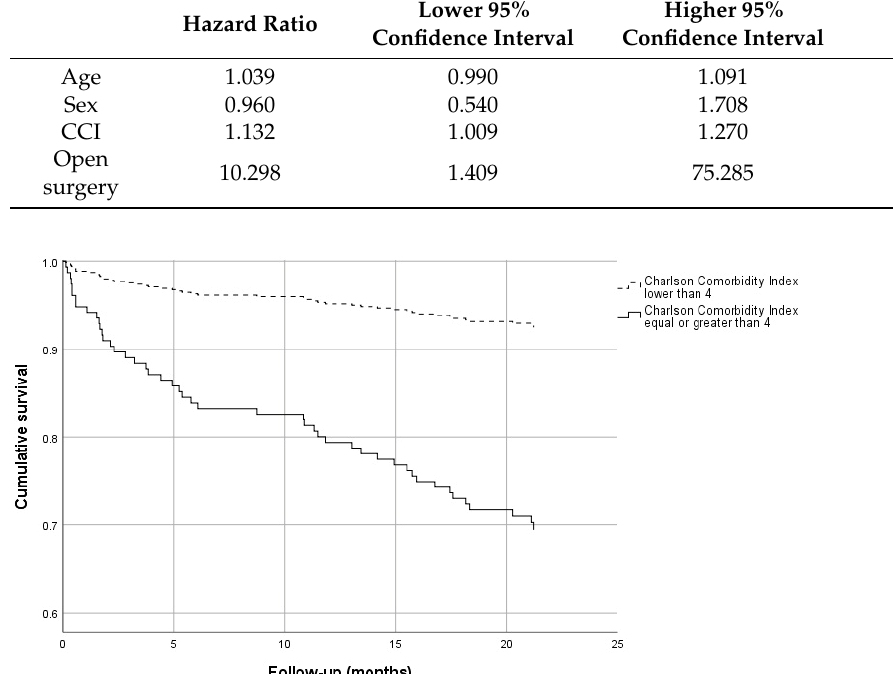
Figure 2. Cumulative survival of individuals undergoing emergency abdominal surgery with Charlson comorbidity index <4 and ≥ 4